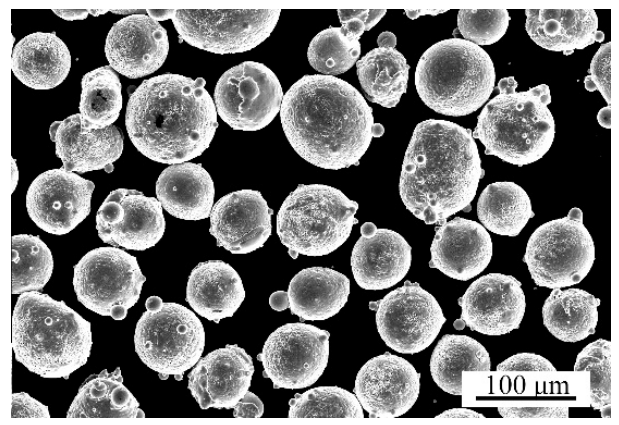
Figure 2. Morphology of the alloyed powder (SEM).